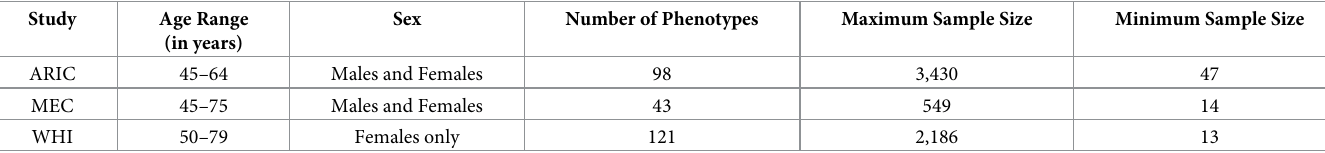
Table 1. Population Architecture using Genomics and Epidemiology (PAGE) I studies available for PheWAS and their characteristics. The Atherosclerosis Risk in Communities (ARIC), Multiethnic Cohort (MEC), and Women’s Health Initiative (WHI) from the PAGE I study contributed data towards this PheWAS. A full list of phe- notypes used in this PheWAS is available in S1 Table. Some of the phenotypes were measured in more than one study, some phenotypes were related to phenotypes of another study, and some phenotypes were unique measurements for a single study. Not all phenotypic measurements were available for all participants within each study. Maximum sample size and minimum sample size are dependent both on which individuals were genotyped and which individuals also had a specific phenotype measured. See Materials and methods for more information.